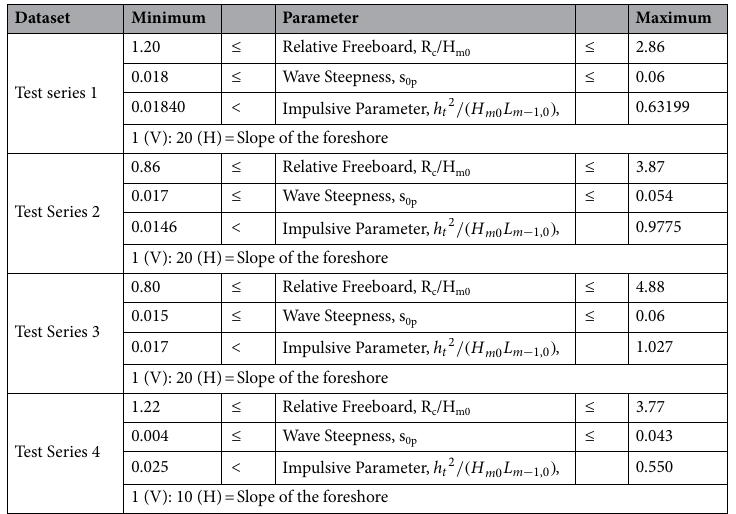
Table 1. Ranges of wave and structural configurations correspond to dataset considered within this